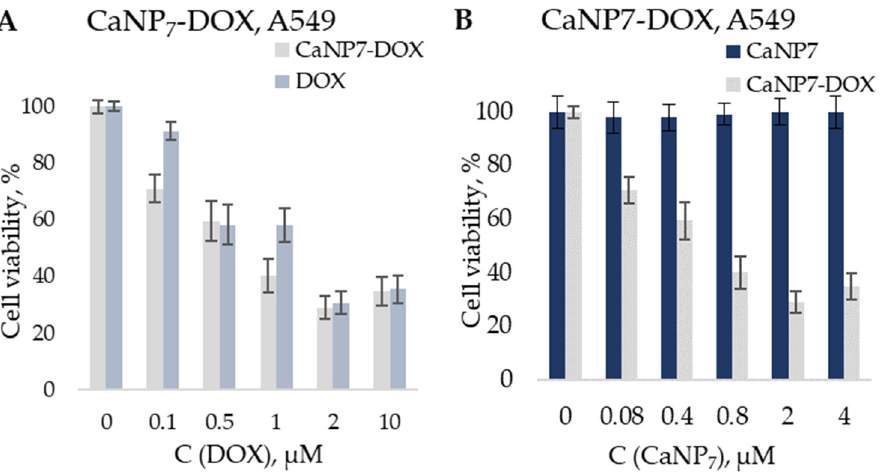
Figure 10. Cytotoxic activity of CaNP 7 , CaNP 7 – DOX , DOX on A549 cells. Cells were incubated with equimolar amounts of DOX , either soluble or loaded on nanoparticles ( A ) as well as with equivalent amounts of nanoparticles ( B ).